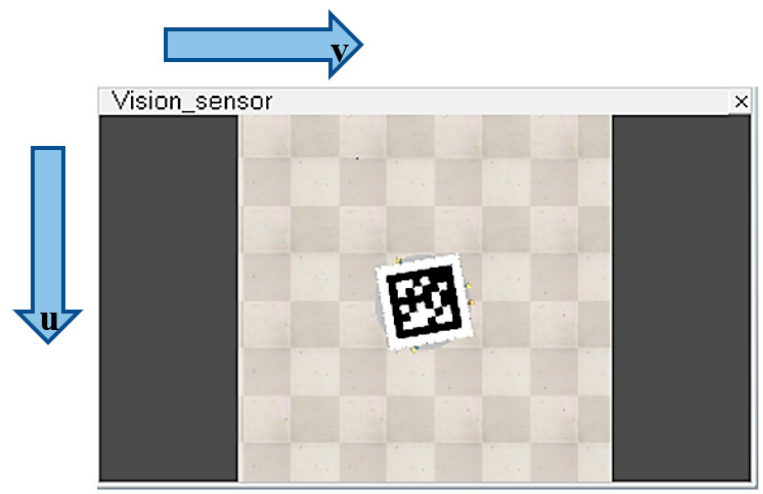
Figure 2. Drone downward camera view of the landing platform-u and v Pixel coordinate.